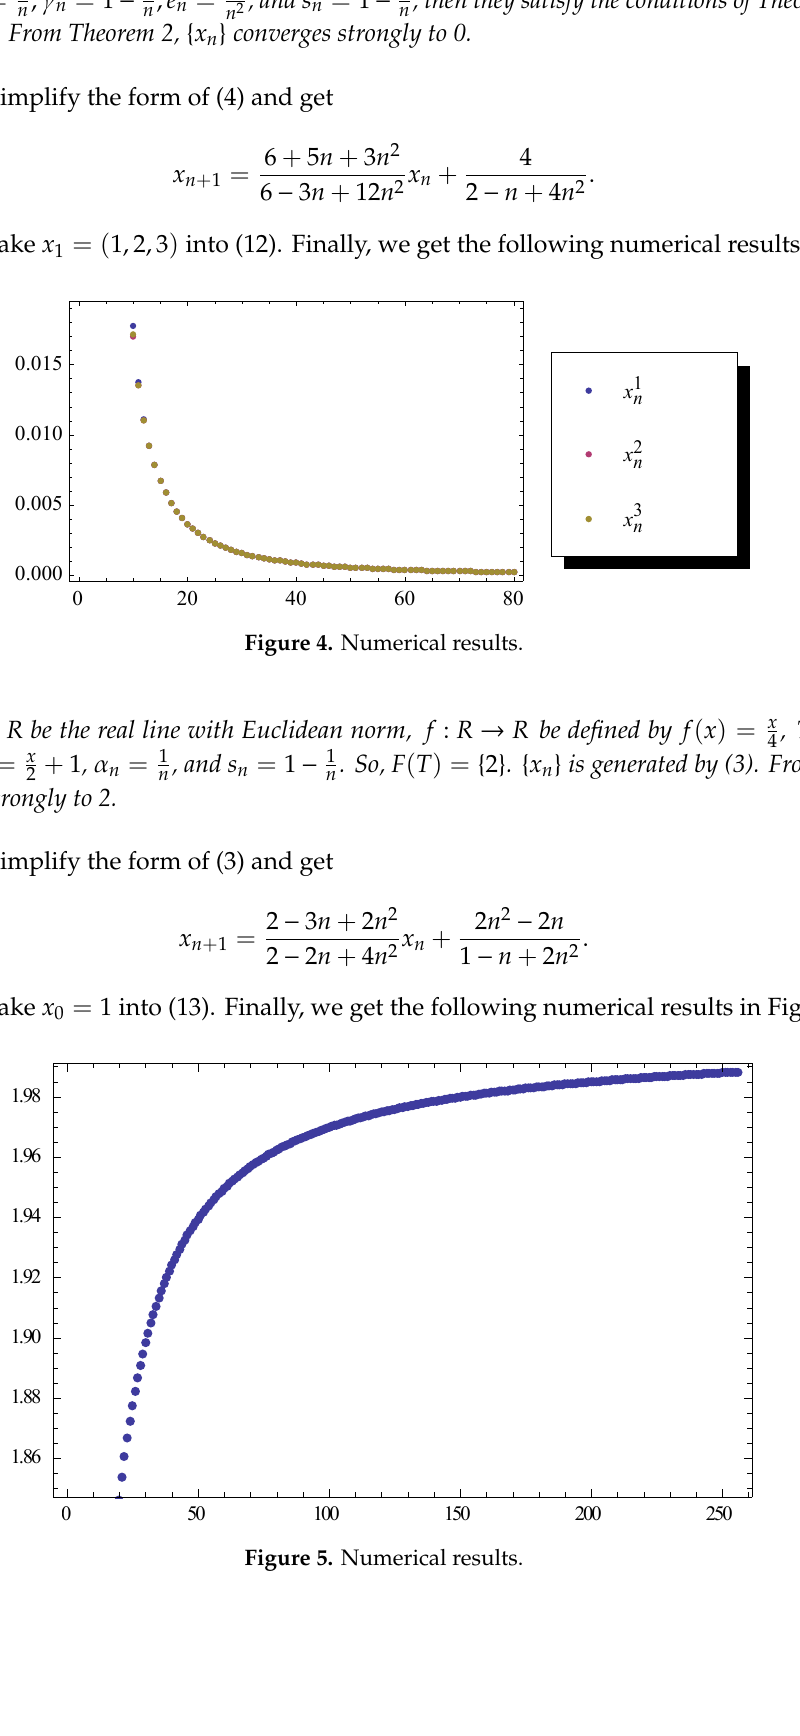
Figure 5. Numerical results.